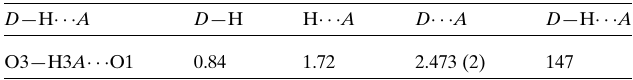
Table 1 Hydrogen-bond geometry (A˚ , (cid:2) ).